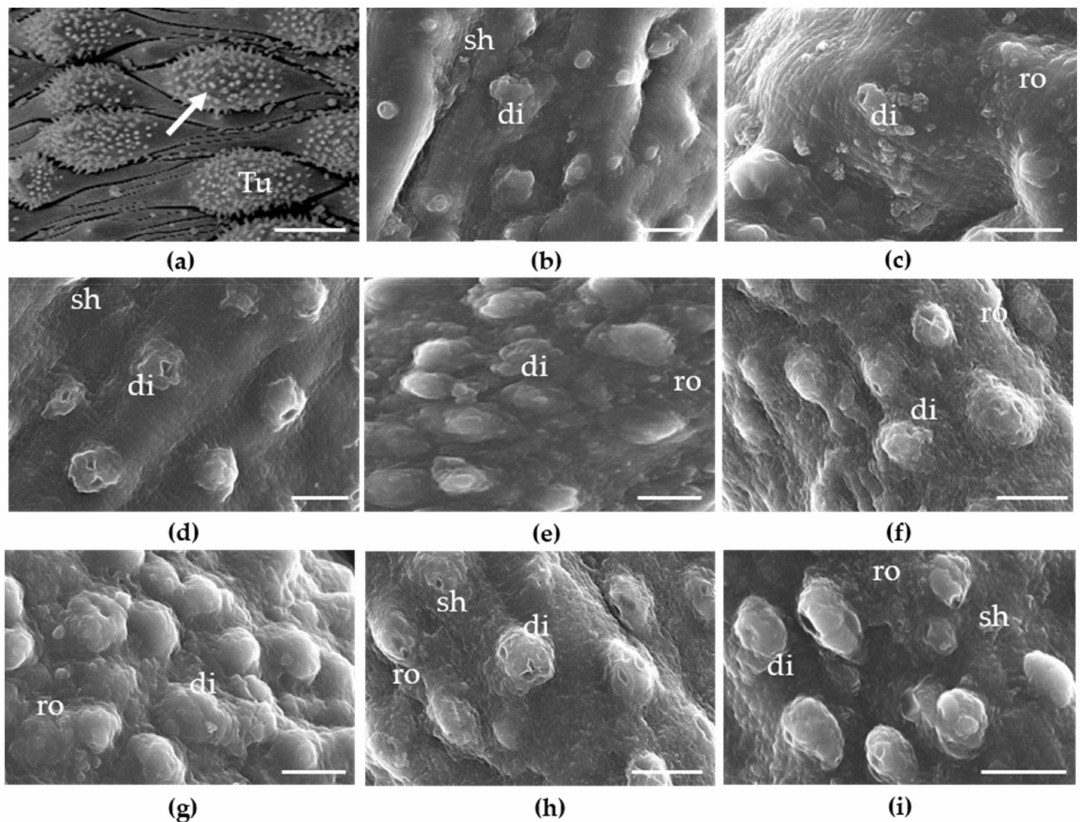
Figure 3. Microscopy observations of S. mansoni male worms after exposure to cardiovascular drugs. Freshly perfused parasites were placed on plates containing various concentrations of cardiovascular agents. ( a ) Control showing tubercles (Tu) and spines on the surface (arrow); ( b ) amiodarone 12.5 µ M; ( c ) amiodarone 25 µ M; ( d ) amiodarone 50 µ M; ( e ) telmisartan 12.5 µ M; ( f ) telmisartan 25 µ M; ( g ) telmisartan 50 µ M; ( h ) propafenone 50 µ M; ( i ) propafenone 25 µ M. Parasites were monitored for up to 72 h and micrographs of the mid-body region of schistosomes show disintegration (di), roughening (ro), and shrinking (sh). Images were obtained using a JEOL SM-6460LV scanning electron microscope. Scale-bars: 10 µ